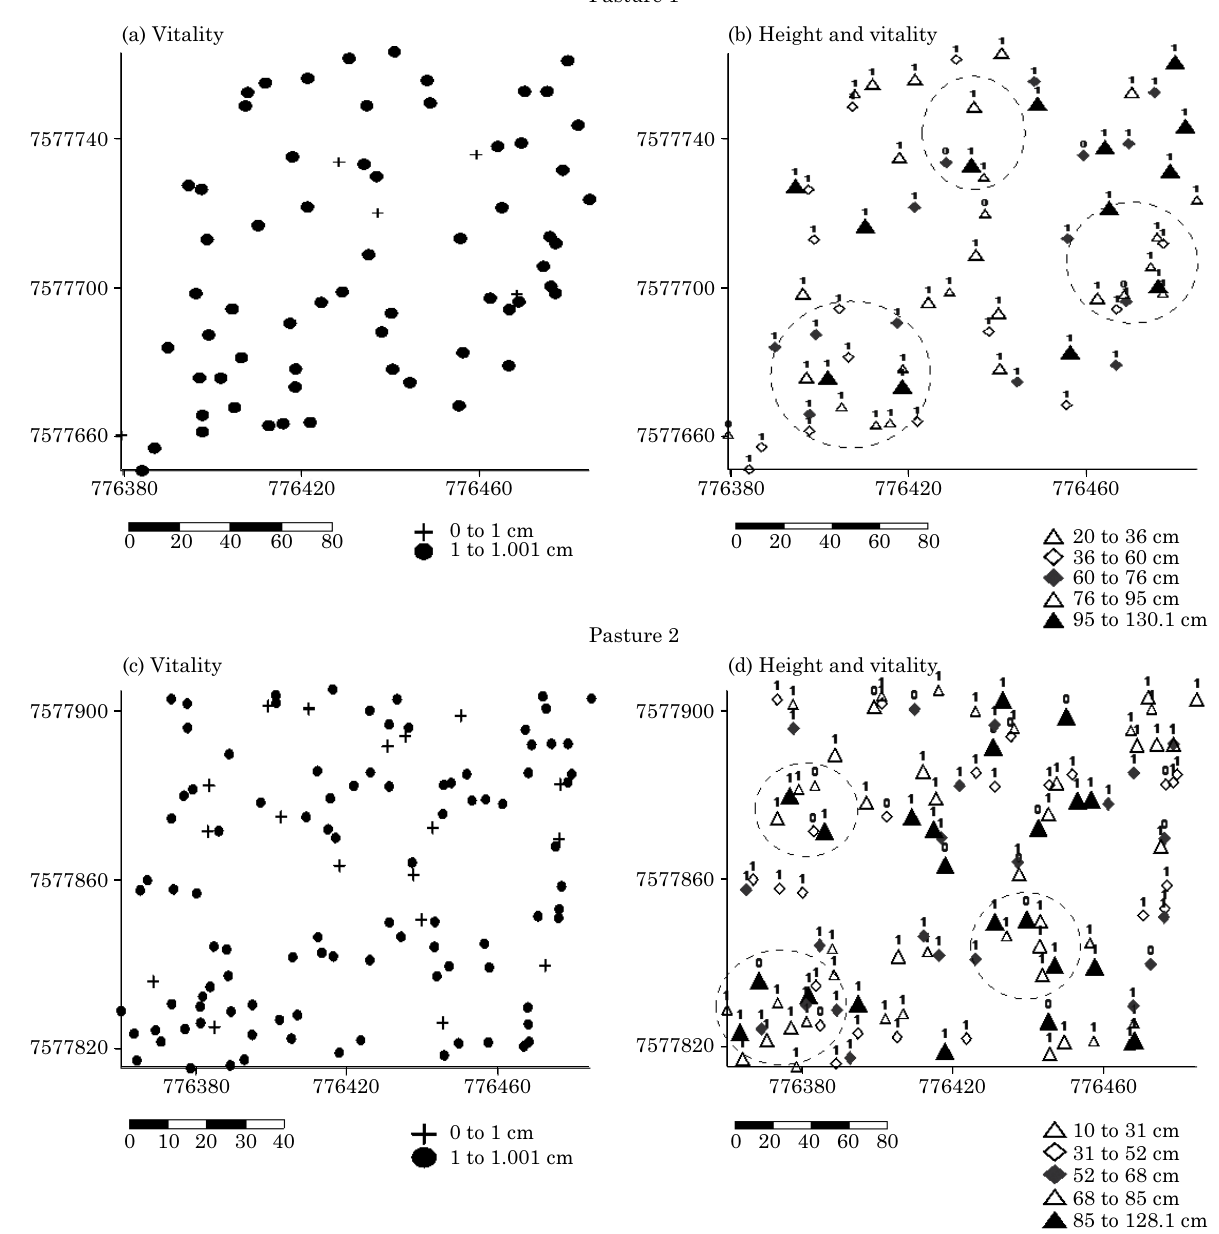
Figure 3. Spatial distribution of the vitality (a, c) and height measurements and vitality (b, d) of epigeous termite mounds in Pasture 1 and 2, respectively, on the Fazenda Campana, Rio Brilhante, MS. (+ = abandoned mounds without termite activity; • = active mounds). The circles in the graph explain the random distribution of